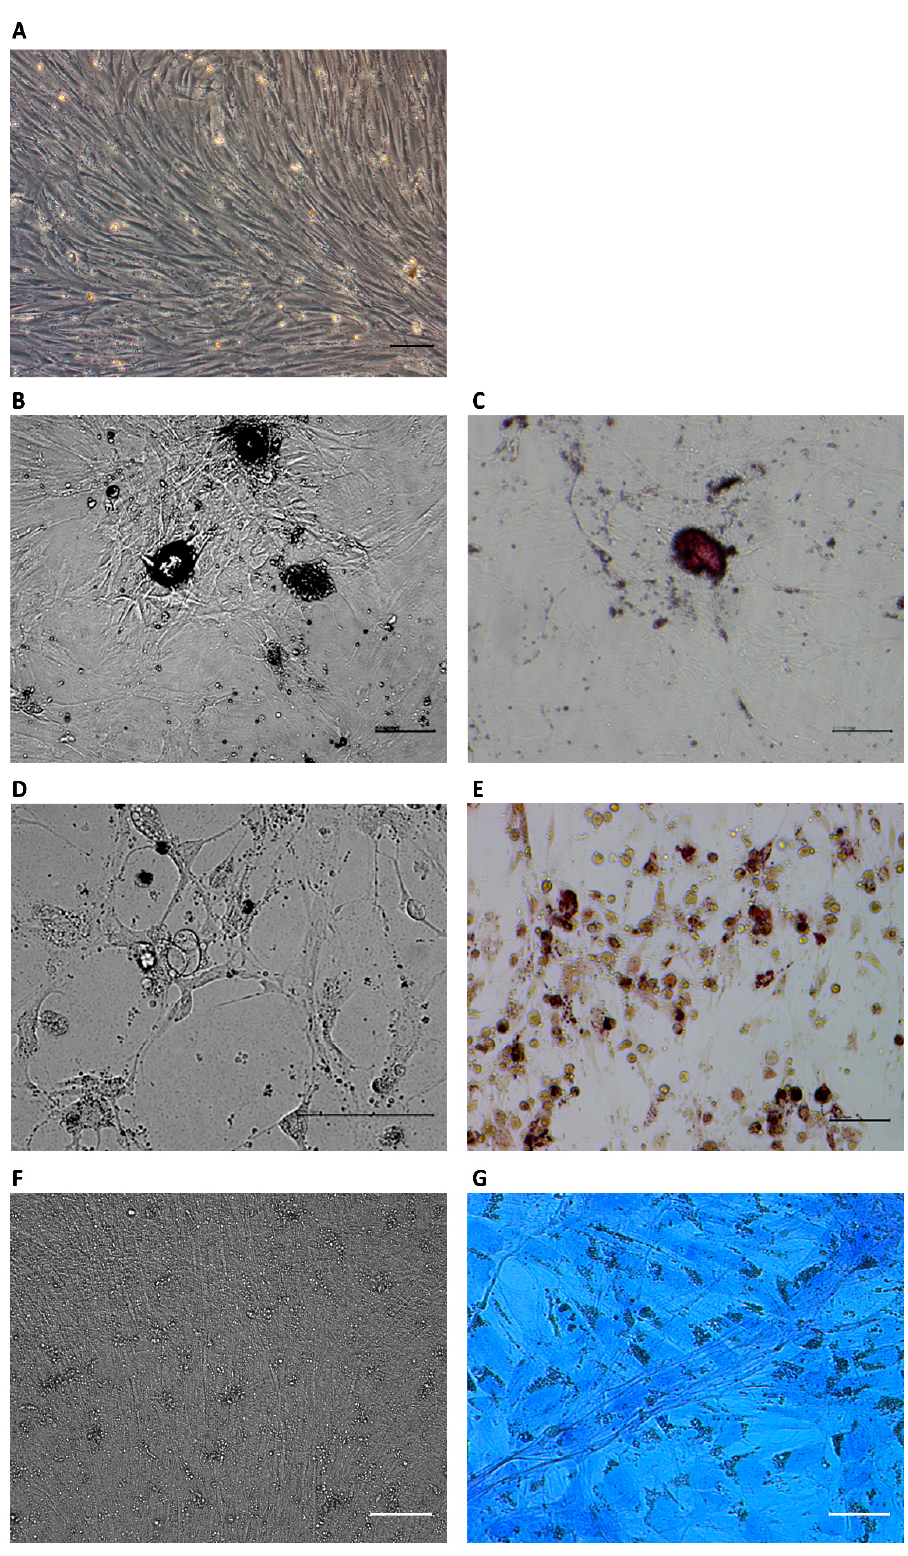
Figure 4. Multilineage differentiation potential of MSCs at P4. Cells before differentiation ( A ). Os- teoblasts derived from MSCs ( B ) were stained with Alizarin Red ( C ). Adipocytes derived from MSCs ( D ) were stained with Oil Red ( E ). Chondrogenic derived from MSCs ( F ) contained proteoglycans stained with Alcian Blue ( G ). Scale bar: 100 µ